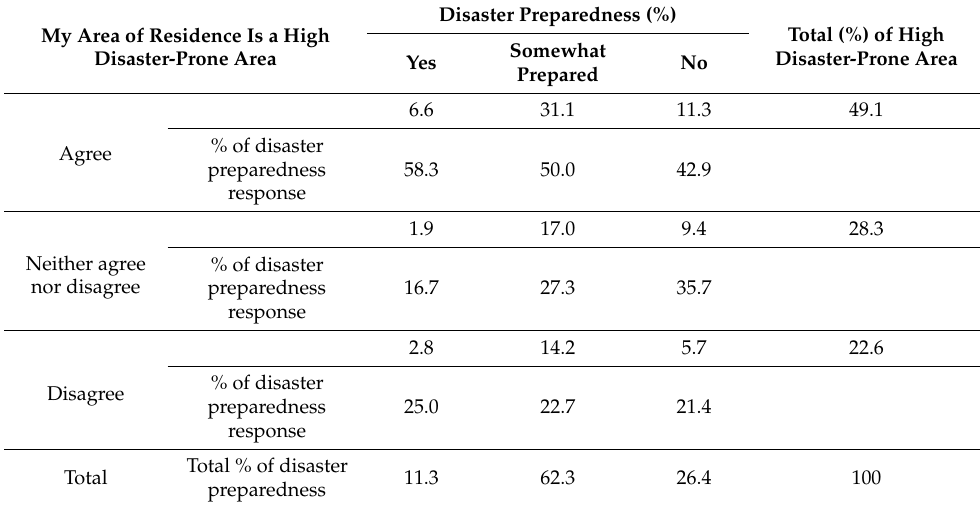
Table 2. Perception of disaster at areas of residence and disaster